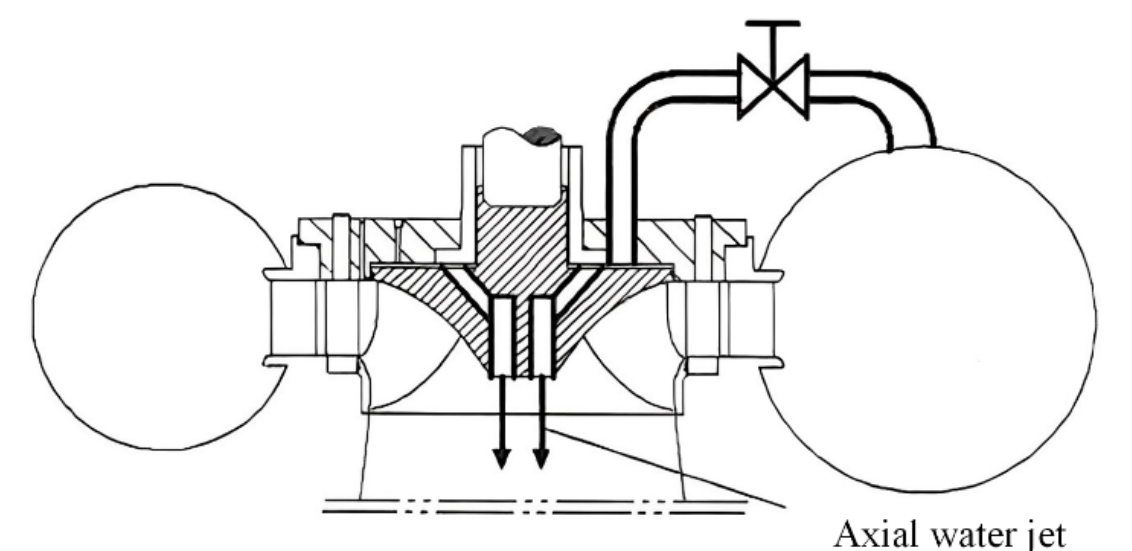
Figure 25. Schematic diagram of the axial water jet structure [36].